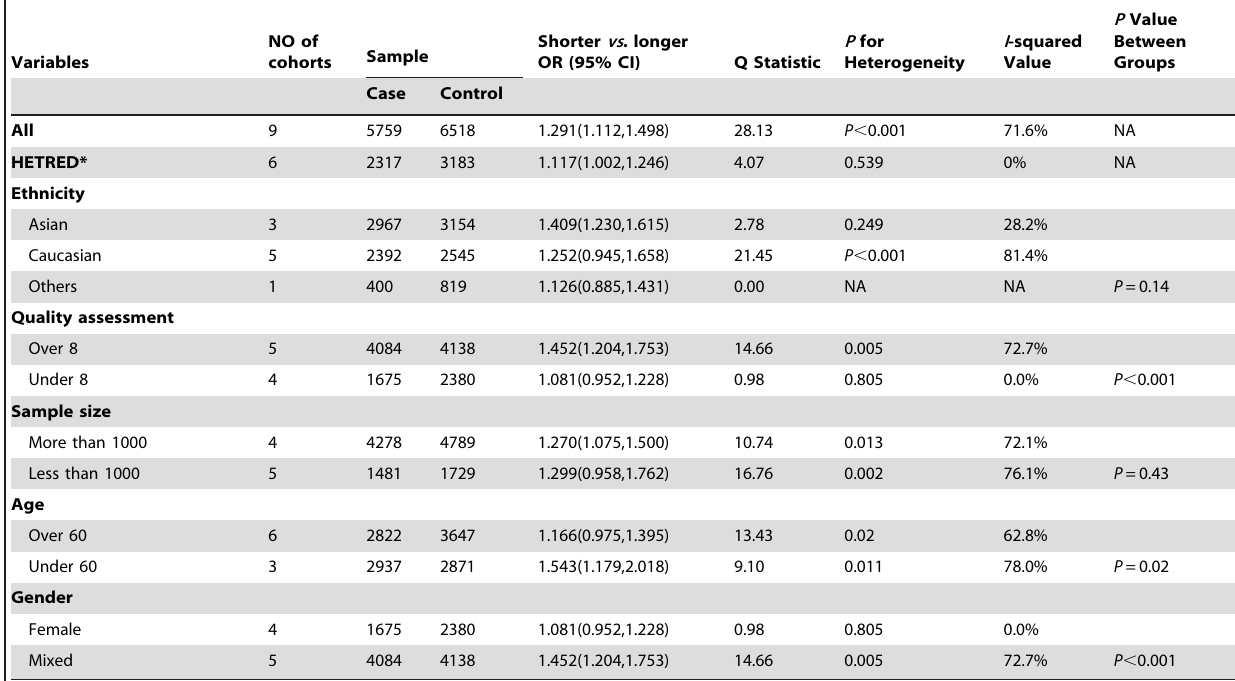
Table 2. Subgroup analyses of the meta-analysis.